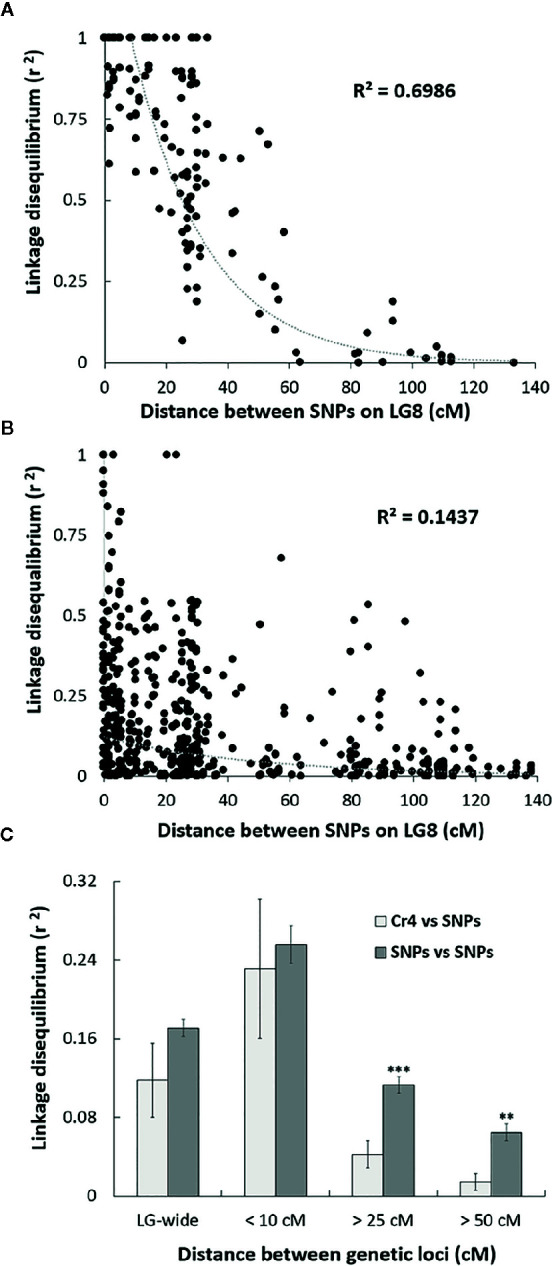
Scatter plot of the estimates (r2) of linkage disequilibrium (LD) decay for pairs of single-nucleotide polymorphisms (SNPs) in Alberta limber pine seed families with major gene resistance (MGR), with genetic distance in centimorgans (cM) within the Pinus consensus linkage group 8 (LG8). The curves are nonlinear regressions of LD decay (r2) onto distance in cM. (A) LD decay detected in the progeny of family PB #2; (B) LD decay detected in the progeny of all four MGR Alberta seed families; (C) Comparison of the LD decay estimates (r2) for pairs of SNPs and for pairs of Cr4 coupling with one SNP locus. Pooled data from all surveyed SNPs were used to estimate LD decay based on distances between two loci at 10, 25, 50 cM, or LG-wide. Two and three stars indicate significant difference by t-test at p < 0.01, and p < 0.001, respectively.